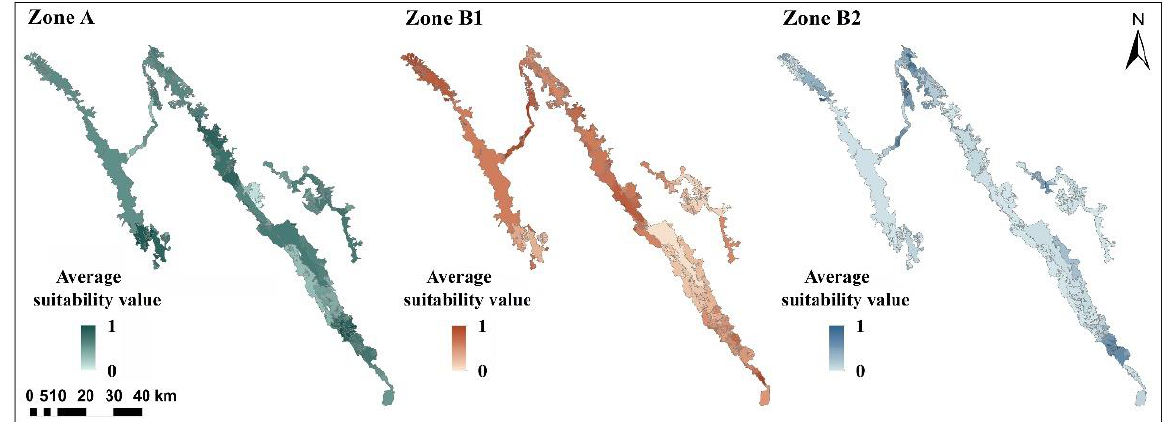
8 of 16 Figure 4. Land suitability maps for Zones A, B1, and B2.